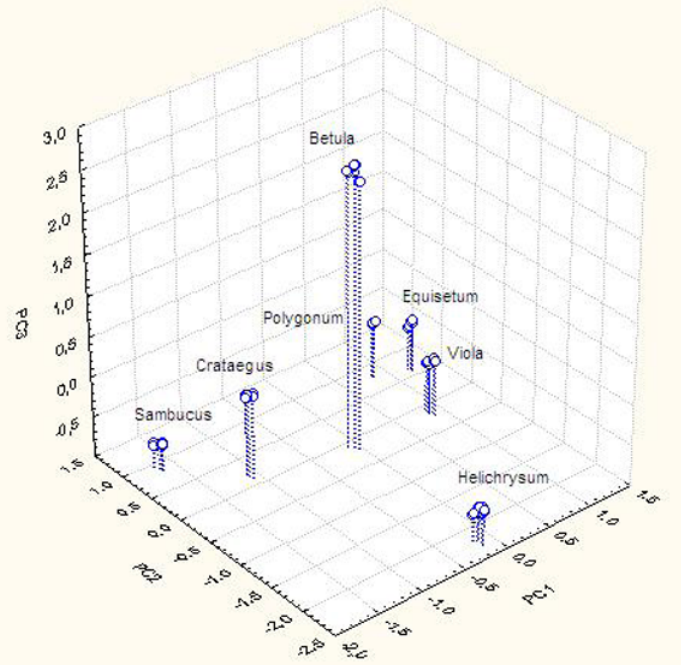
Figure 1. The 3D score plot for PC1 versus PC2 and PC3 for all